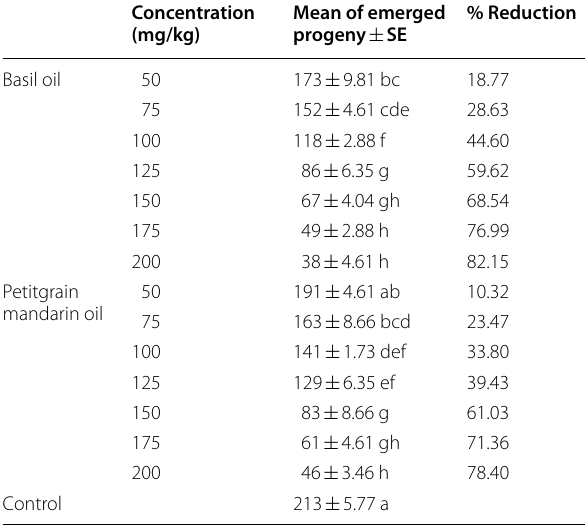
In the same column, means followed by the same letters are not significantly different at 0.05 level according to Duncan multiple range test